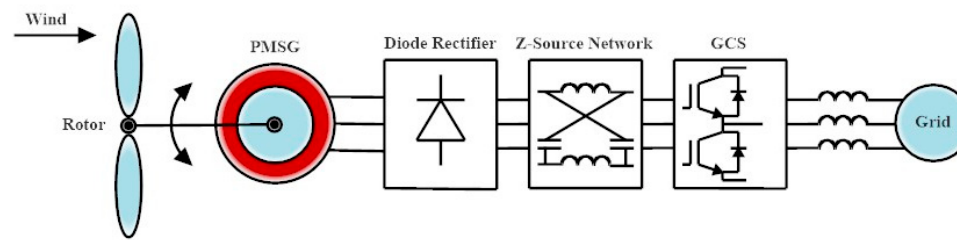
Figure 20. Z-Source inverter (ZSI). Table 5. Comparison of types of Power Converters [59–63].